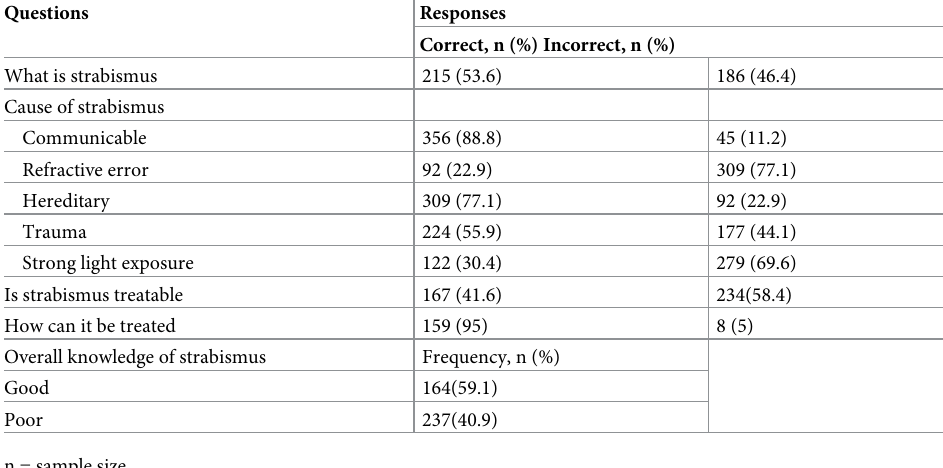
Table 2. Knowledge of strabismus among adult participants living in Woreta, Northwest Ethiopia, 2020 (n = 401).